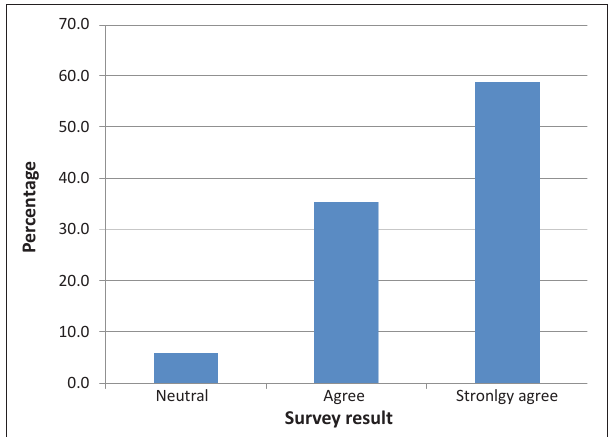
FIGURE 5: Should items be classified in terms of risk?